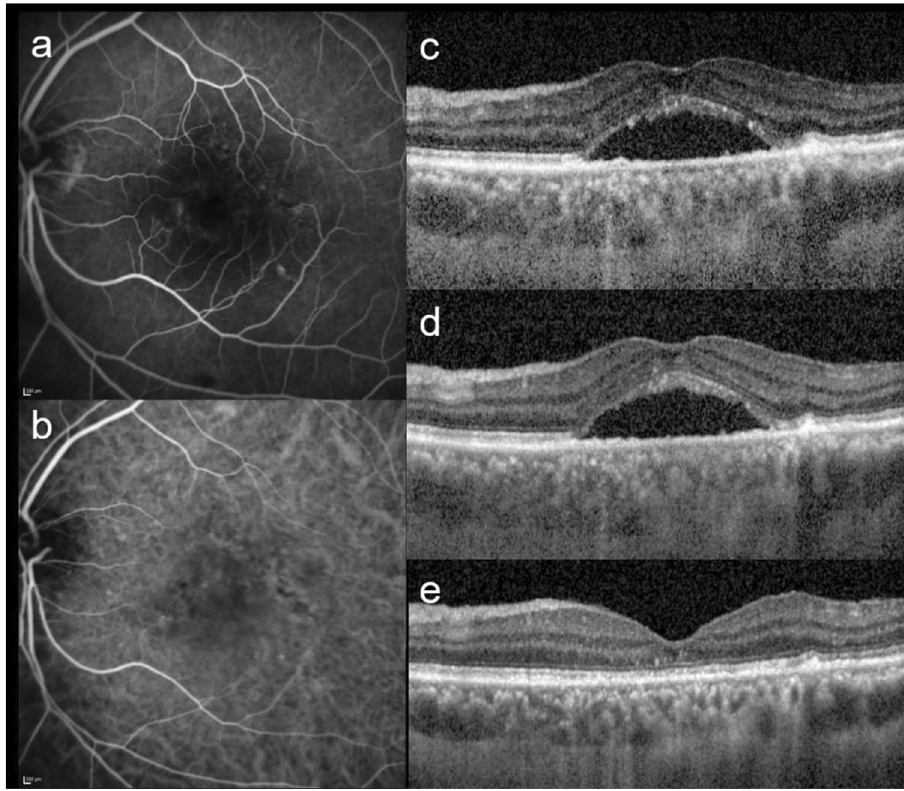
Figure 1. This is a representative case of PAEM-. Fluorescein angiography ( a ), indocyanine green angiography ( b ), and horizontal line of optic coherence tomography images of patients at baseline ( c ), 3 days follow-up ( d ) and 1 month follow-up ( e ) after photodynamic therapy (PDT). 60-year-old-male with central serous chorioretinopathy in the left eye. Central retinal thickness was 358 µm at baseline, 364 µm (+ 1.7%) at 3 days, 122 µm (− 65.9%) at 1 month after PDT. Central choroidal thickness was 338 µm at baseline, 341 µm (+ 0.9%) at 3 days, 255 µm (− 24.6%) at 1 month after PDT. Complete resolution of sub retinal fluid was seen at 1 month